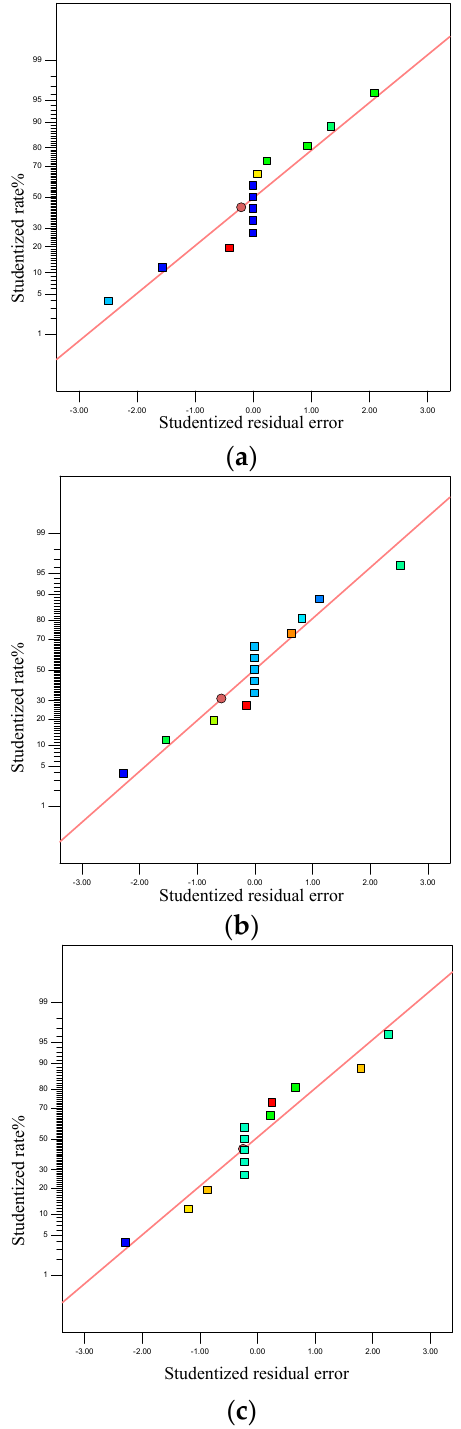
Figure 5. Normal residual diagram of powder quality from DEM simulation: ( a ) normal residual diagram of apparent density; ( b ) normal residuals of standard deviation of the density; ( c ) normal residual diagram of powder surface roughness.